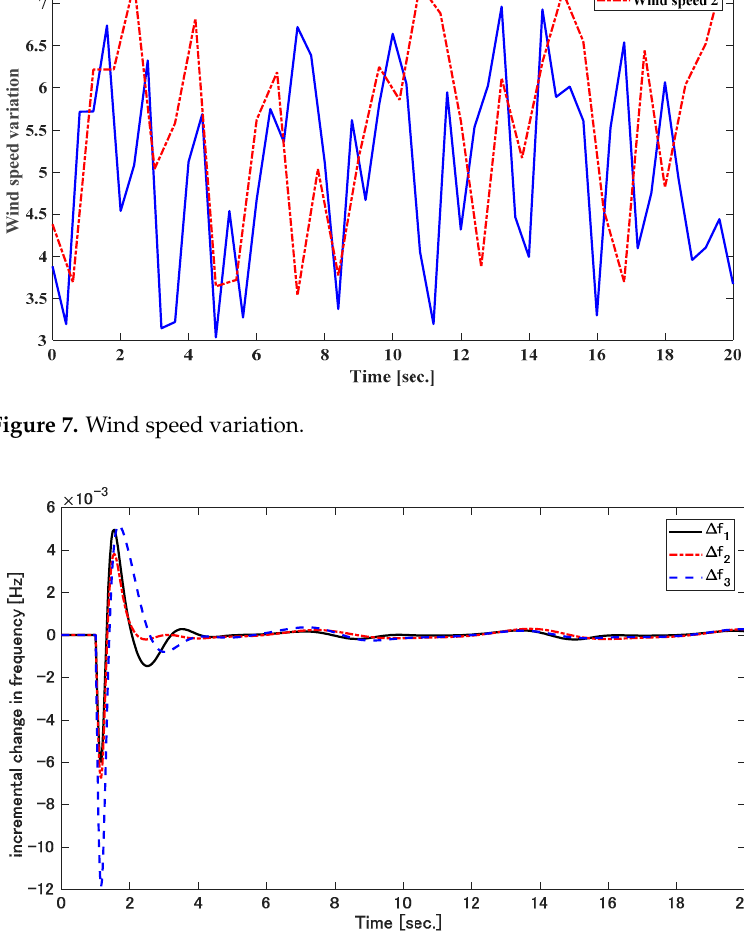
Figure 8. Frequency deviation of three-area power system without a wind plant.